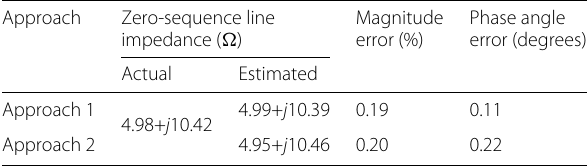
Table 1 Estimated vs. Actual Zero-sequence Line Impedance of Line 1